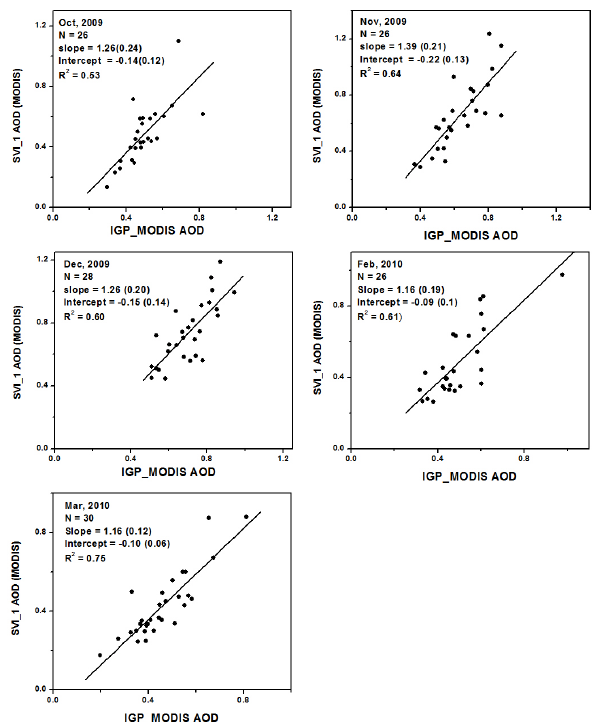
Fig. 14. Comparison of daily mean IGP MODIS to local (SVI 1) scale MODIS aerosol optical depth (AOD) during different months. The IGP MODIS represents the mean of the AOD over the region shown as dashed line in Fig. 1. Standard errors for slope and Y offset at 95% confidence are given in brackets.